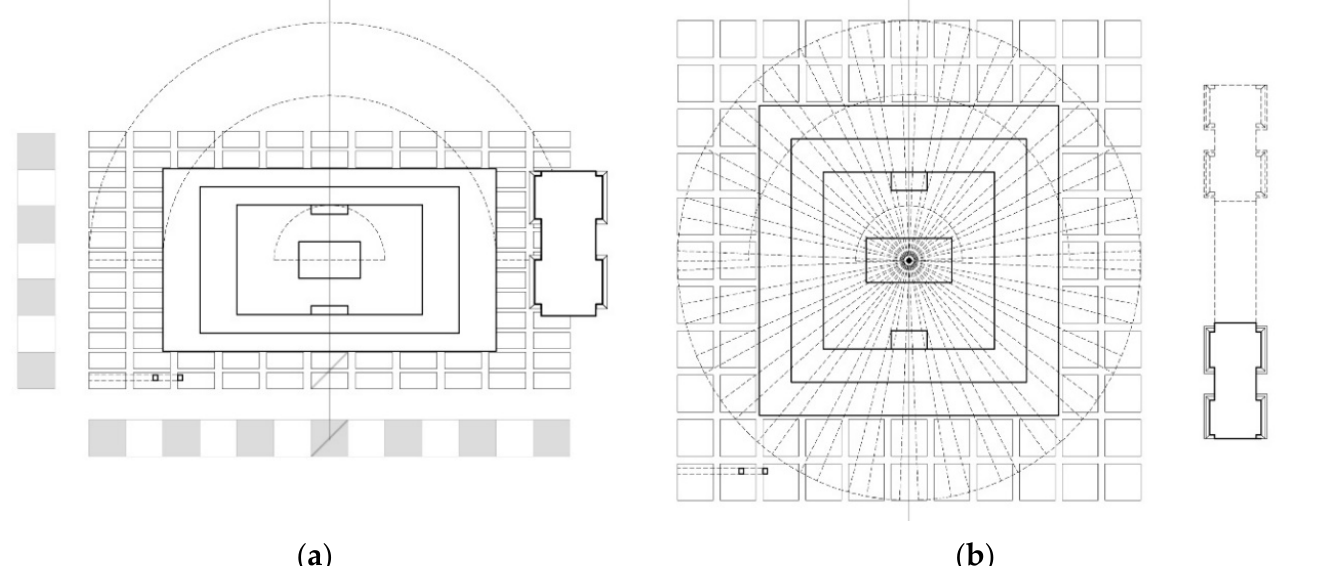
Figure 18. Comparison between the actual plan after the perspective restitution ( a ) and the plan suggested by the vision ( b ) of Raffaello’s The Disputa .